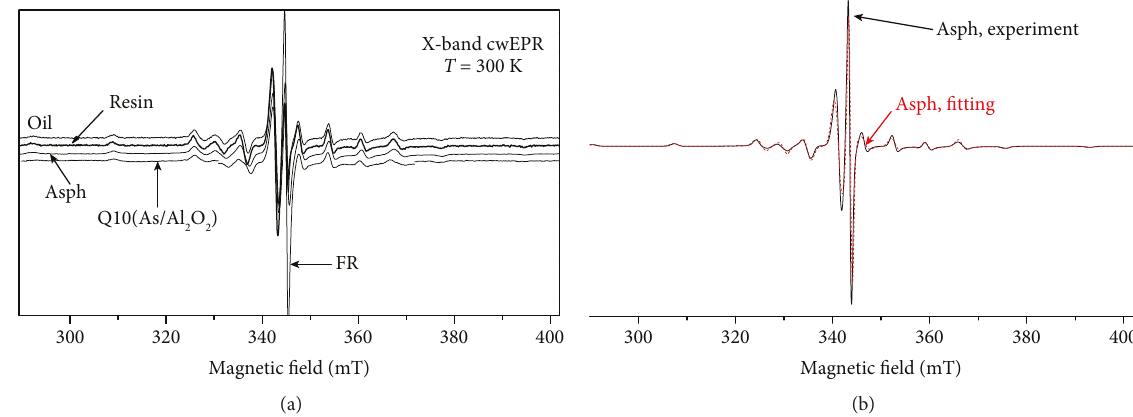
Figure 2: (a) conventional X-band EPR spectra of oil, resins, and asphaltenes and deposited on alumina surface asphaltenes (sample Q10) at room temperature. The signal belonging to FR is marked. Other EPR components originate from VP complexes. (b) example of the experimental (black solid line) asphaltene EPR spectrum fi tting (red dashed line) in the EasySpin package for MatLab [59] with the parameters given in Table 2.